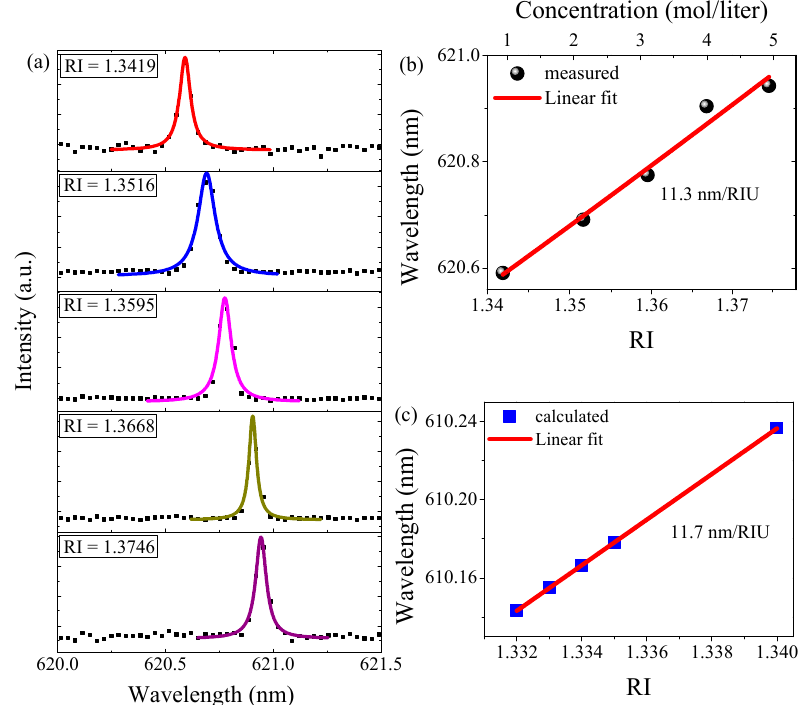
Figure 4. ( a ) Lasing spectrum shift by slightly increasing the refractive index (RI) of the water droplet. Insets show the RI of the NaCl solutions. ( b ) Measured wavelengths of the lasing modes as a function of the NaCl concentration (top x -axis) and RI of the water droplet (bottom x -axis); the measured data is linear fitted. ( c ) The calculated RI sensitivity.